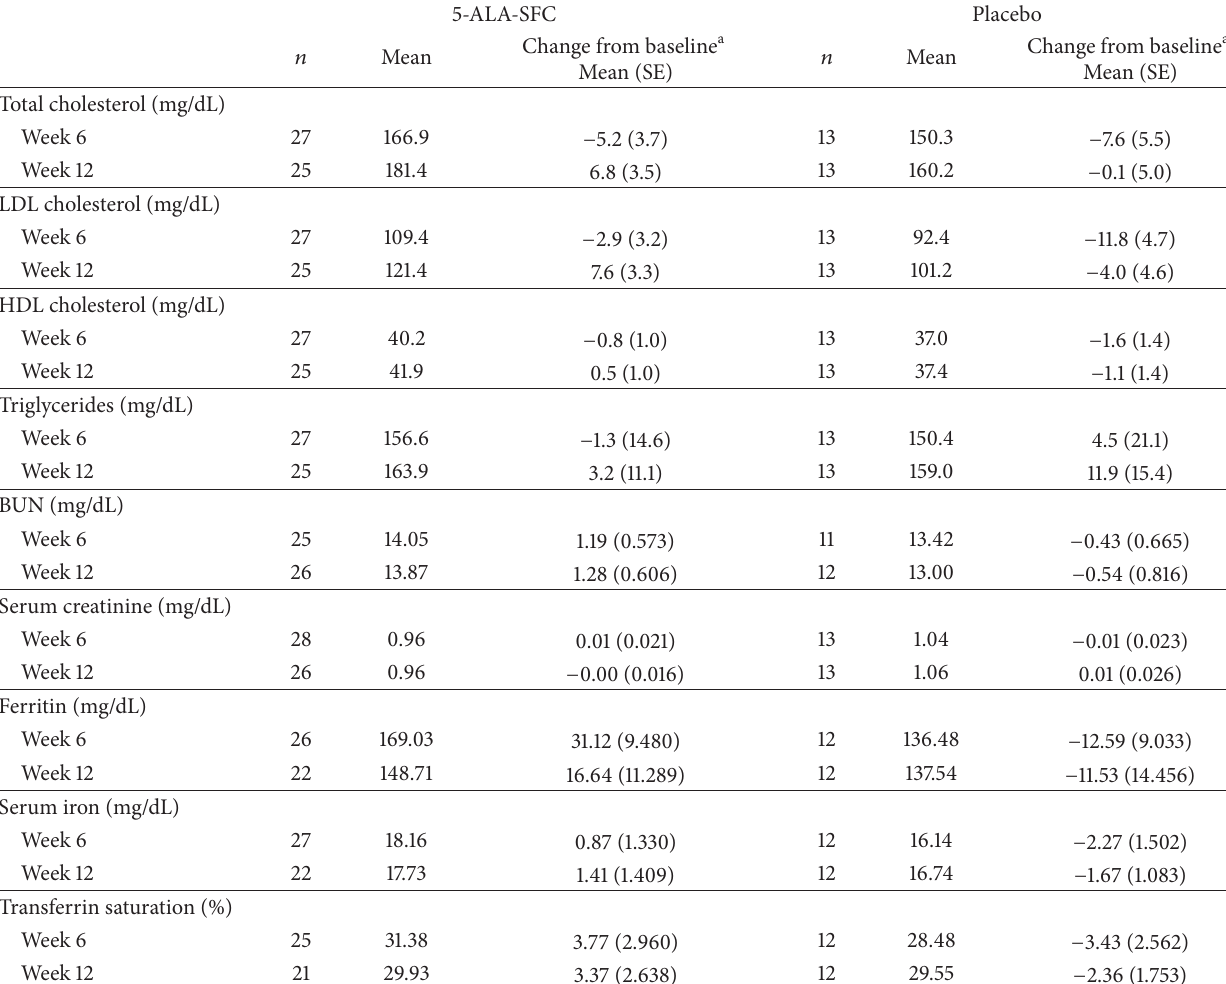
Table 4: Laboratory parameters at week 6 and week 12.